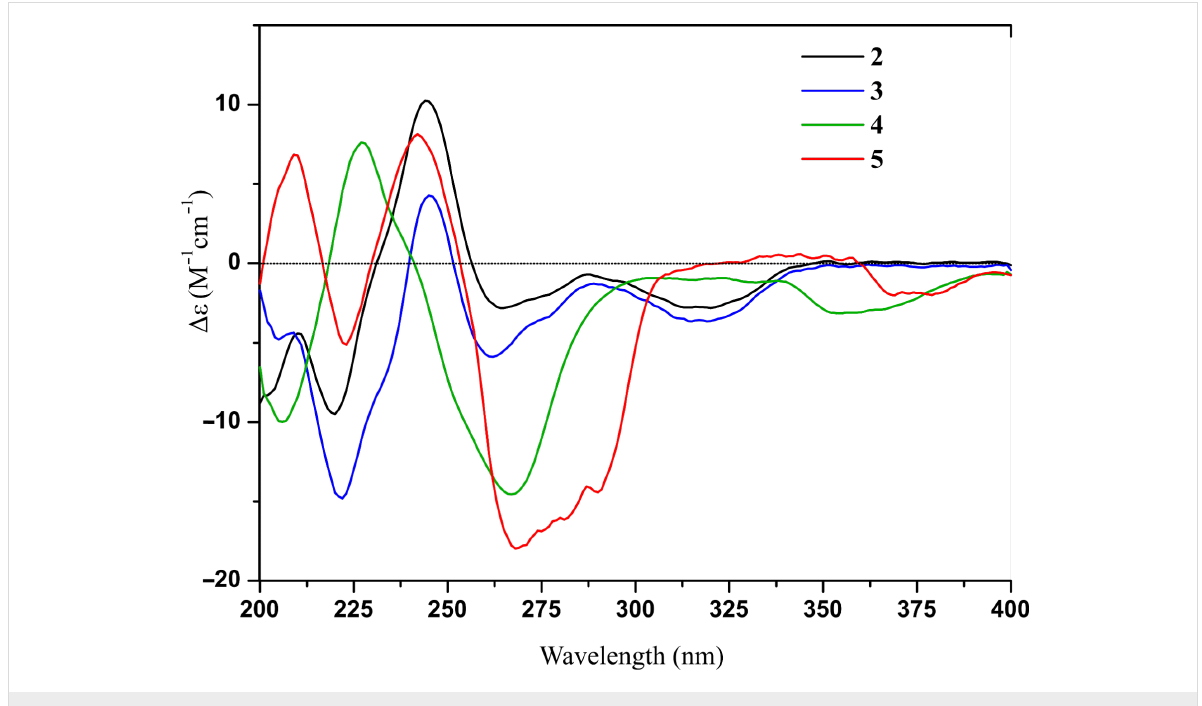
Figure 5: The experimental ECD spectra of 2 – 5 .